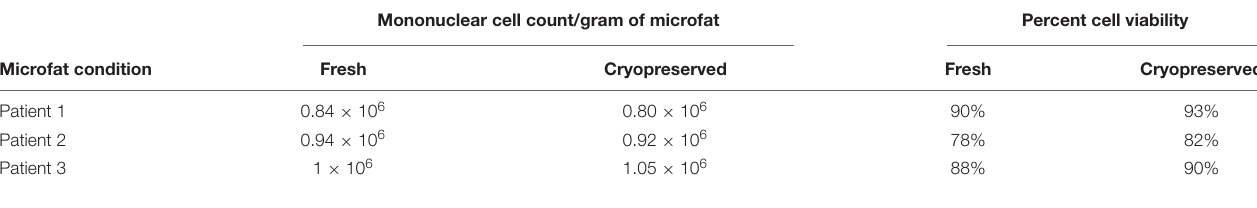
TABLE 2 | Cell count and percent cell viability – fresh vs. cryopreserved